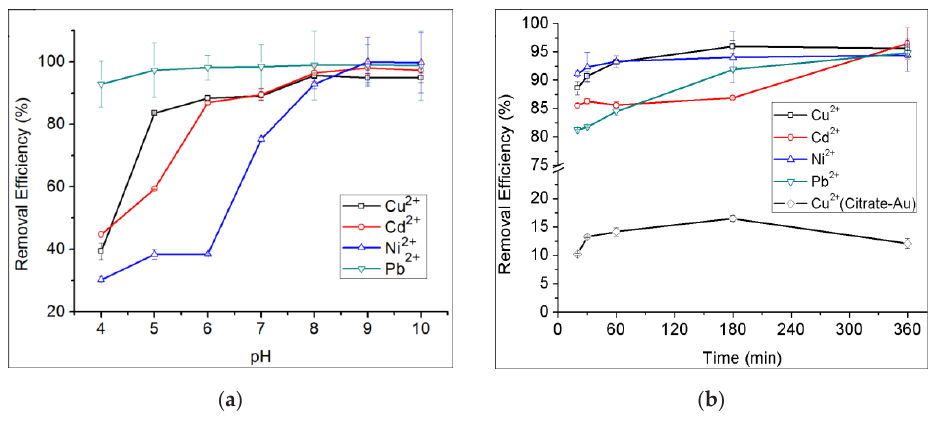
Figure 7. ( a ) The removal efficiency of proanthocyanidin-gold nanoparticles for 20 mg/L of Cu 2+ , Cd 2+ , Ni 2+ and Pb 2+ at pH 4.0–10.0 after incubation for 6 h; ( b ) the removal efficiency of proanthocyanidin-gold nanoparticles for 20 mg/L of Cu 2+ , Cd 2+ , Ni 2+ and Pb 2+ at adsorption time from 20 min to 360 min under pH 8.0. The removal efficiency of citrate-gold nanoparticles for the removal of Cu 2+ was also tested for comparison.